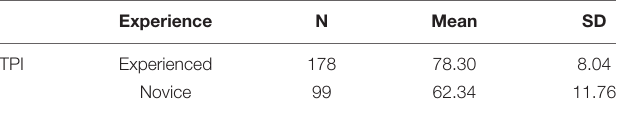
TABLE 4 | Descriptive statistics for experienced and novice teachers’ TPI.